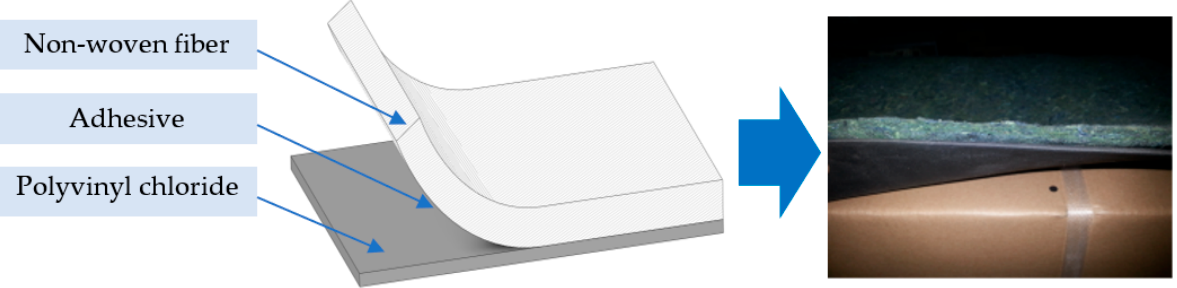
Figure 1. Schematic diagram of double-layer sound insulation structures.